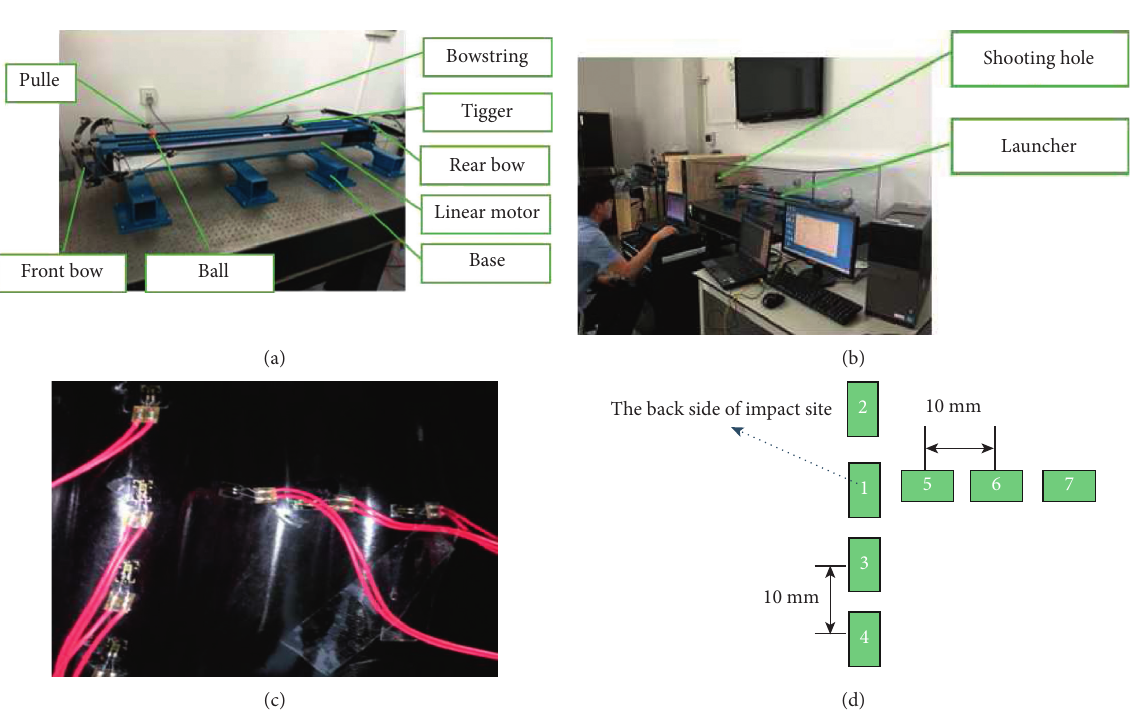
Figure 2: The picture of flying stone launcher. (a) Flying stone launcher. (b) Acceleration device. (c) Strain gauges attached to the back of the shell. (d) Attachment position of the back strain